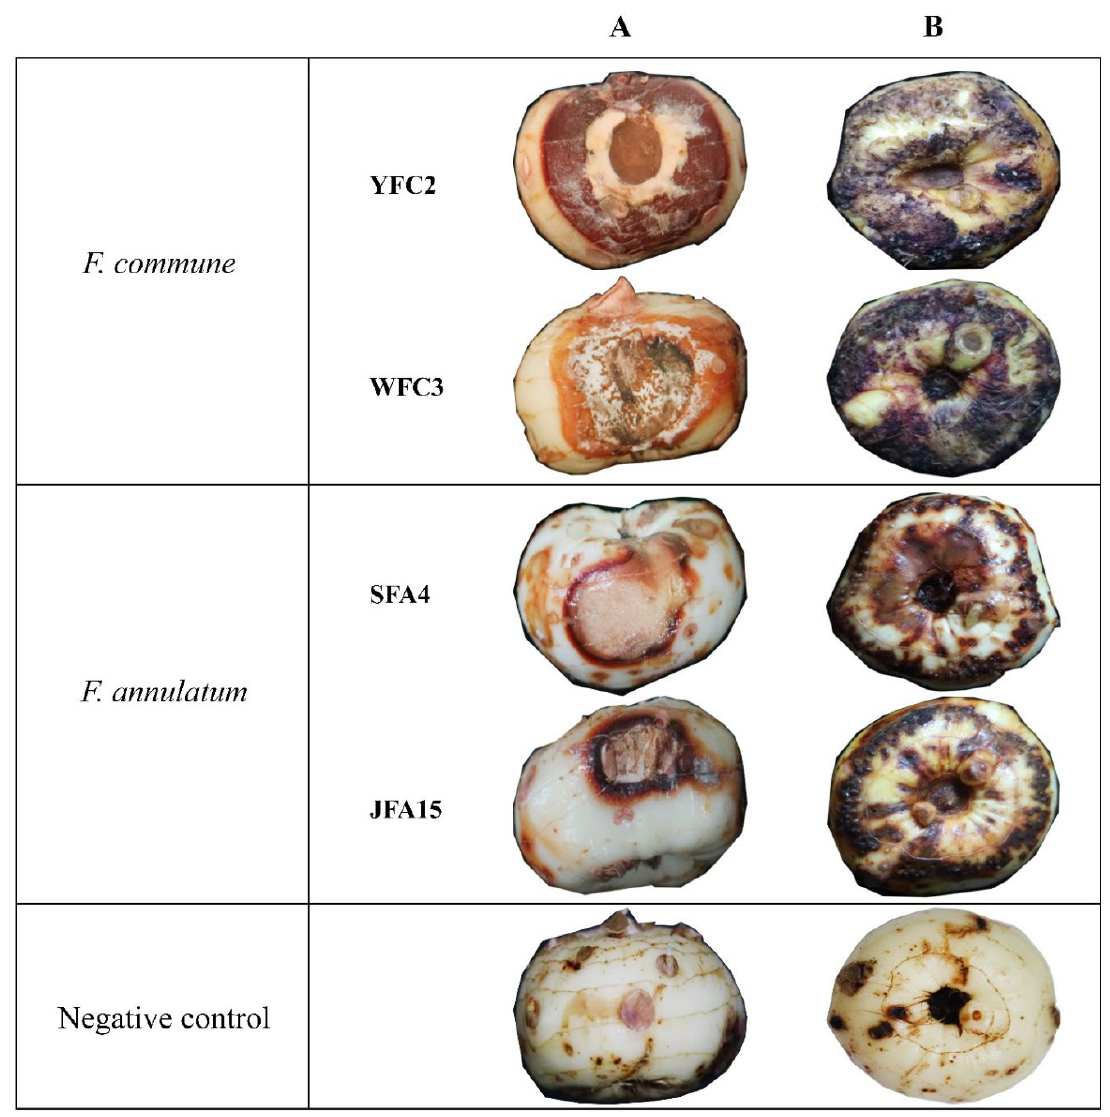
Figure 4. Pathogenicity of F. commune and F. annulatum isolates on C. sativus . ( A ) Corm rot symptoms resulting from inoculation with mycelial plugs. ( B ) Symptoms of rot on corms inoculated with conidial suspensions.